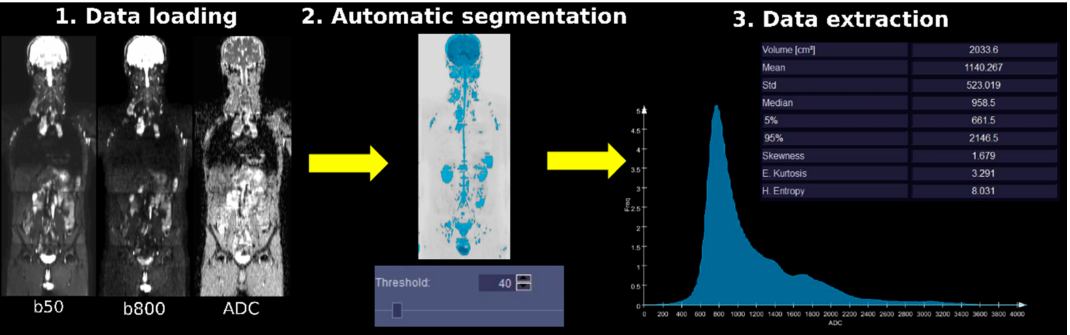
Figure 1. Whole-body di ff usion weighted imaging (WB-DWI) image analysis and data extraction process using syngo.via Frontier MR Total Tumor Load software. Using the WB-DWI images as input (1. Data Loading step), b800 images were automatically segmented using setting a signal intensity threshold (e.g., 40%) at each WB-DWI acquisition time point (e.g., T0). No subsequent mask editing was made (2. Automatic segmentation). The overall mask volume (di ff usion volume, DV) and the corresponding apparent di ff usion coe ffi cient (ADC) histogram metrics associated with the masked volume were extracted (3. Data extraction step). Yellow arrows link the three processing